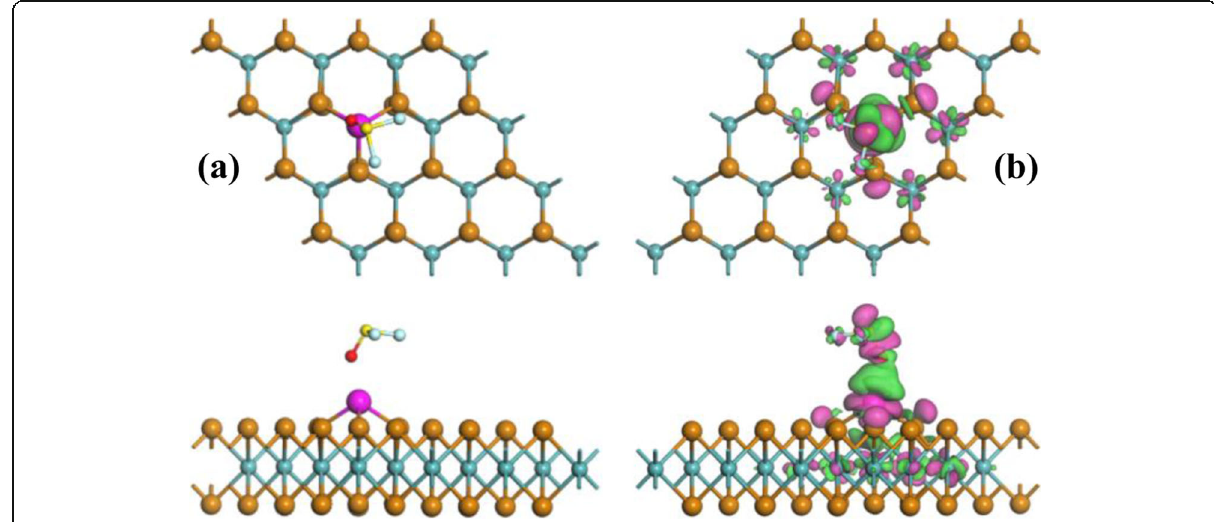
Fig. 4 Same as Fig. 3 but for Rh-MoTe 2 /SOF 2 system